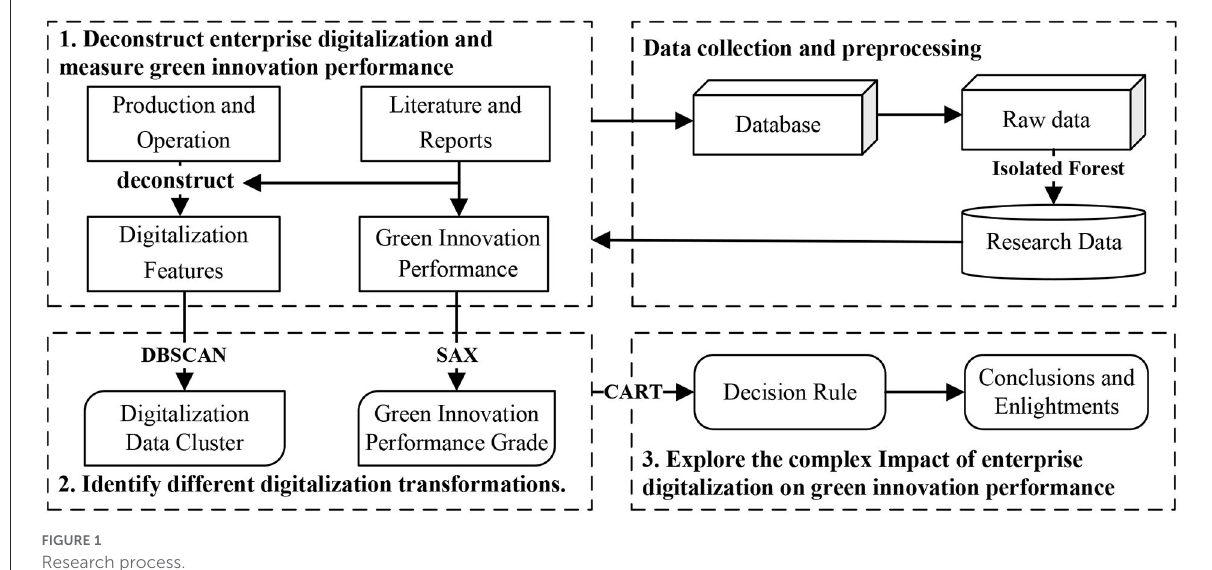
FIGURE1 Research